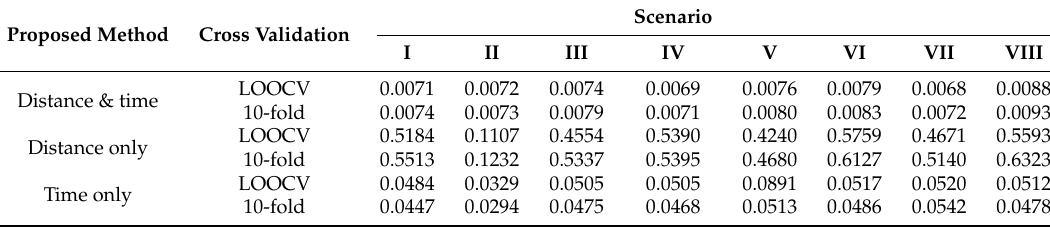
Table 4. Results for the RMSE based on the linear regression analysis of the eight drivers’ frame data for each proposed scenario. (RMSE: the root mean square error, time: time of movement)